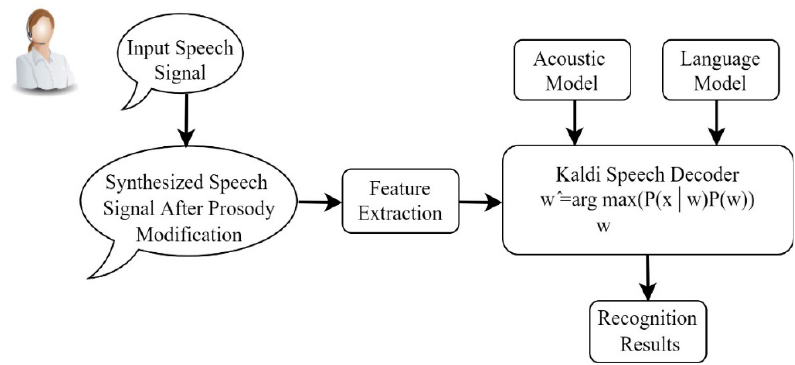
Figure 1. ASR model for recognizing children’s speech with acoustic variabilities.